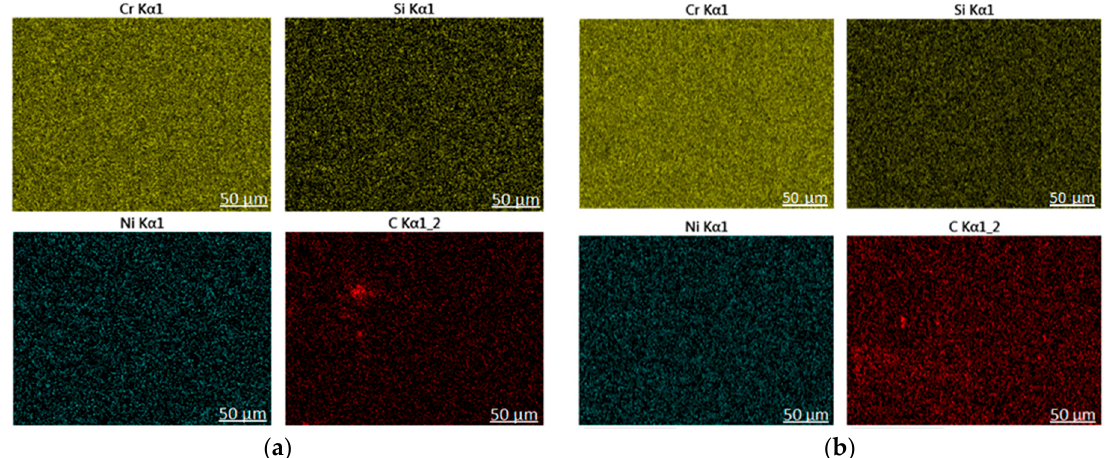
Figure 8. Scanning of the upper and middle regions of the cladding layer. ( a ) Upper area of the cladding layer; ( b ) middle area of the cladding layer.